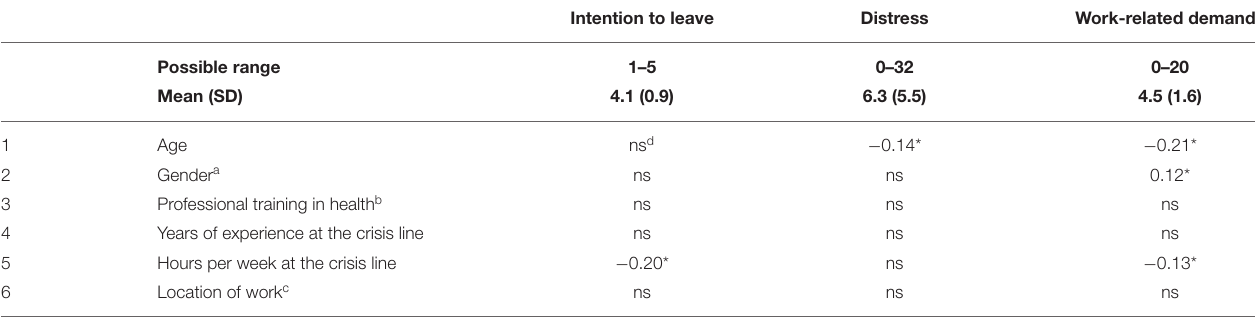
TABLE 4 | Correlations between variables and means, and standard deviations of the scale variables.